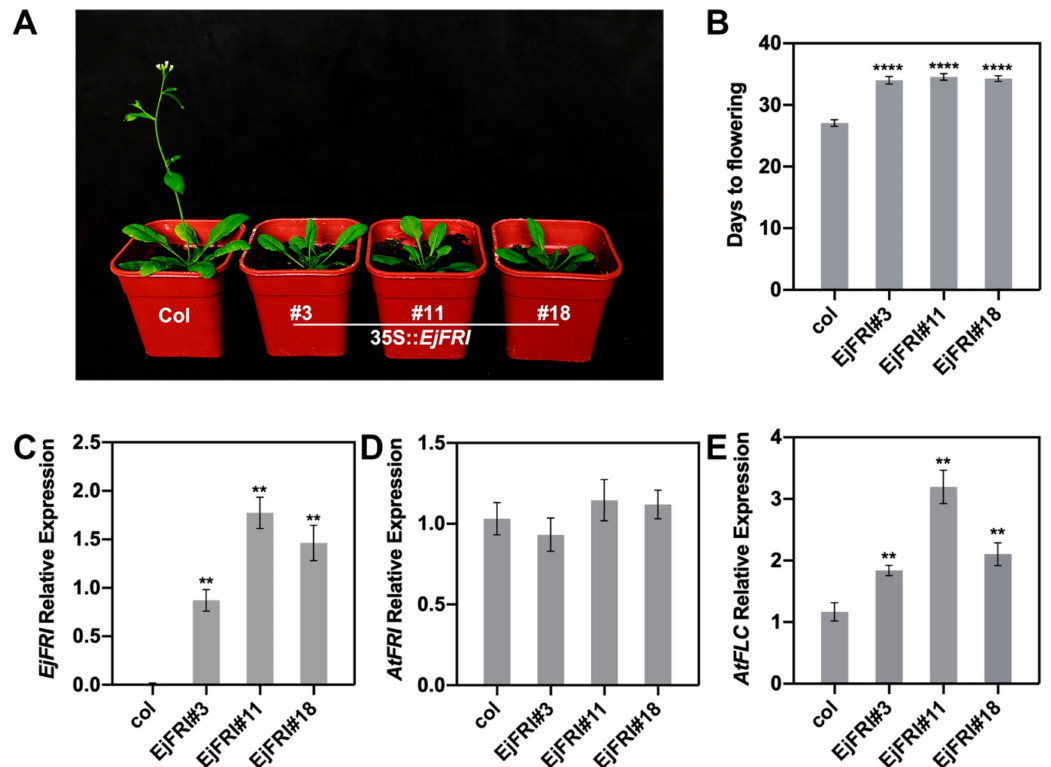
Figure 5. Overexpression of EjFRI delayed flowering Arabidopsis. ( A ) Transgenic plants delayed flowering compared to WT. ( B ) Flowering time grown under LD condition (Error bars indicating SD from 20 plants). ( C , D , E ) Expression levels of EjFRI , AtFRI and AtFLC in WT and transgenic plants (data represent mean ± SD of three biological replicates). The leaves of WT and transgenic plants were collected after flower bloom and used for qRT-PCR analysis. Asterisks indicate significant di ff erences between WT and transgenic plants, ** p < 0.01, **** p < 0.0001, by Student’s t